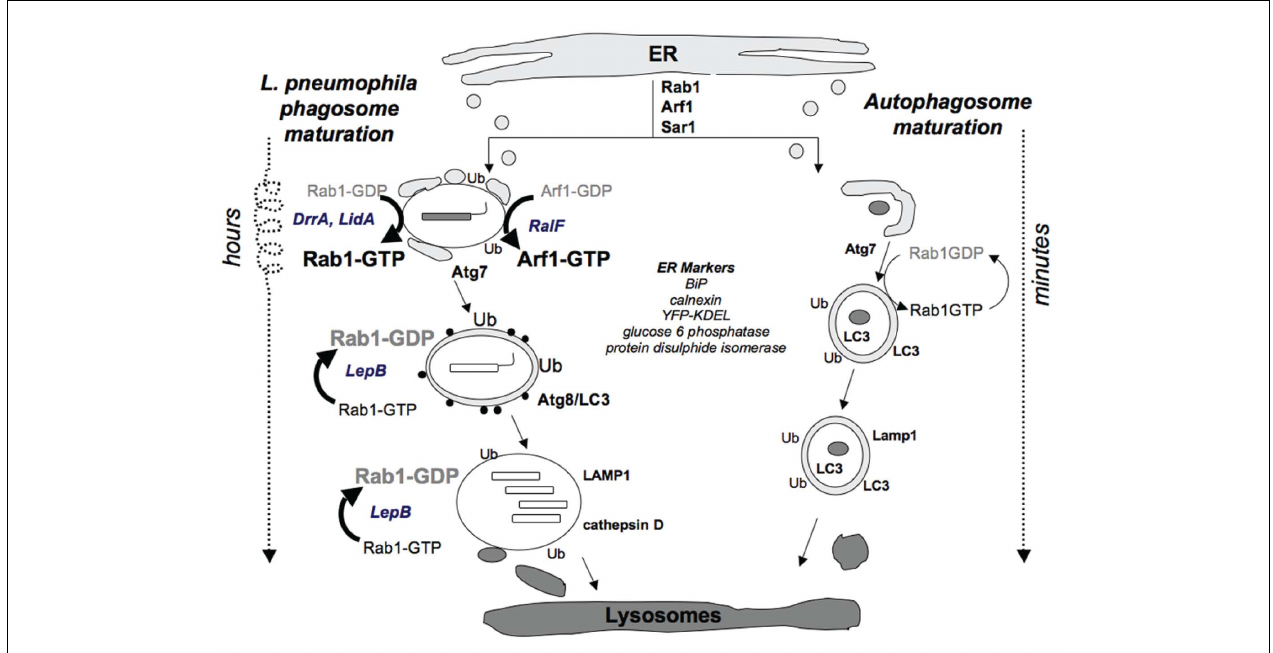
Rab1 and RalF activates Arf1.Thus, the vacuole acquires ER markers BiP, glucose-6-phosphate, calnexin, protein disulfide isomerase,YFP–KDEL, and ribosomes (filled circles). After several hours, L. pneumophila secretes LepB, an effector that inactivates Rab1, releasing it from the membrane. Subsequently, the immature autophagosomal vacuole matures to an autophagolysosome, which accumulates the lysosomal proteins cathepsin D and LAMP1.The deliberate pause coordinated byType IV secretion effectors enables the pathogen to differentiate into an acid-resistant, replicative form that exploits lysosomes as a replication